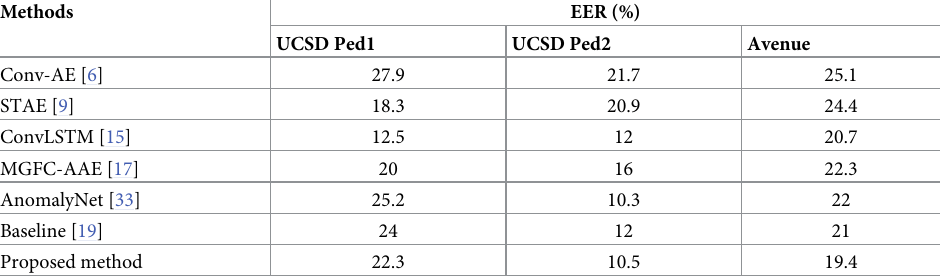
Table 2. Comparison of EER values on different